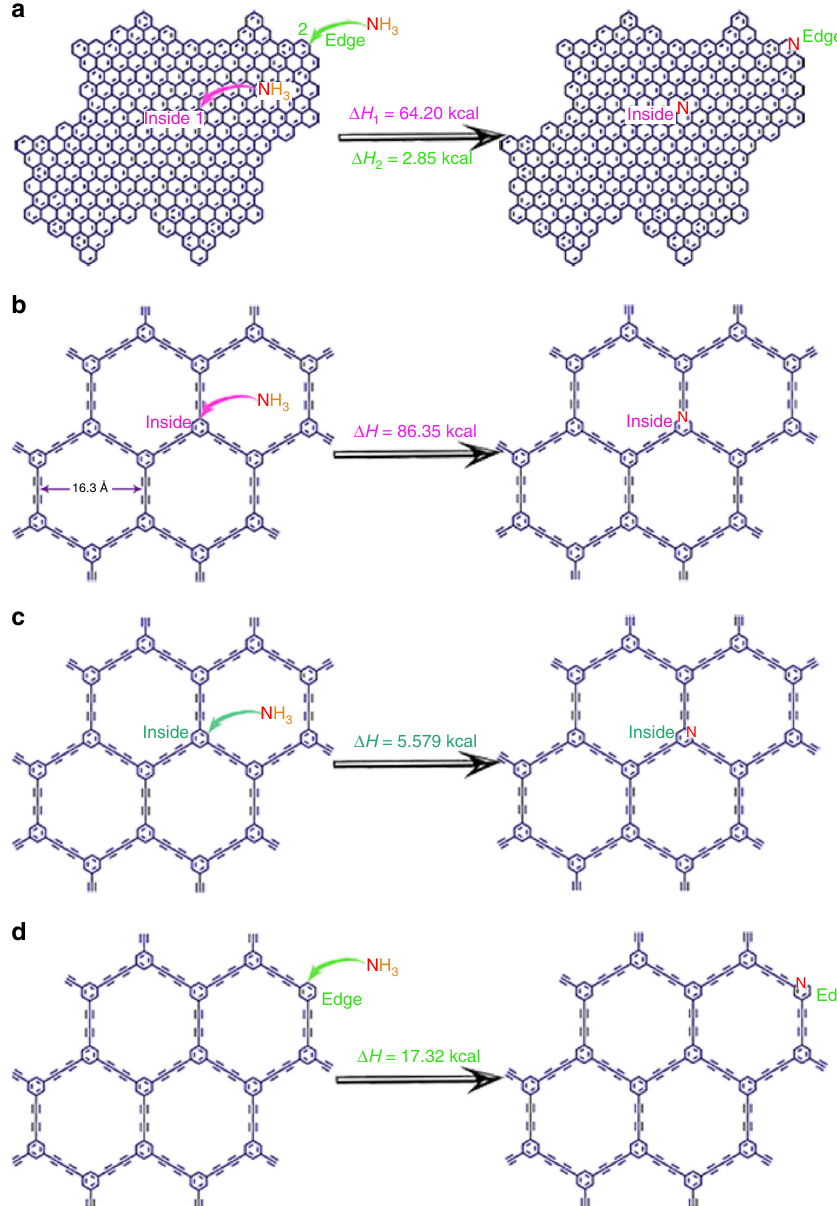
Fig. 3 Reaction equations and enthalpy changes. a A reaction equation and enthalpy changes for substituting C in graphene with N. b A reaction equation and enthalpy change for substituting C linked to a acetylenic bond in hydrogen-substituted graphdiyne (HsGDY) with graphitic N. c A reaction equation and enthalpy change for substituting C on the inside of HsGDY with pyridinic N. d A reaction equation and enthalpy change for substituting C at the edge of HsGDY with pyridinic N. The C in the benzene ring at the edge of HsGDY was linked with H ( d